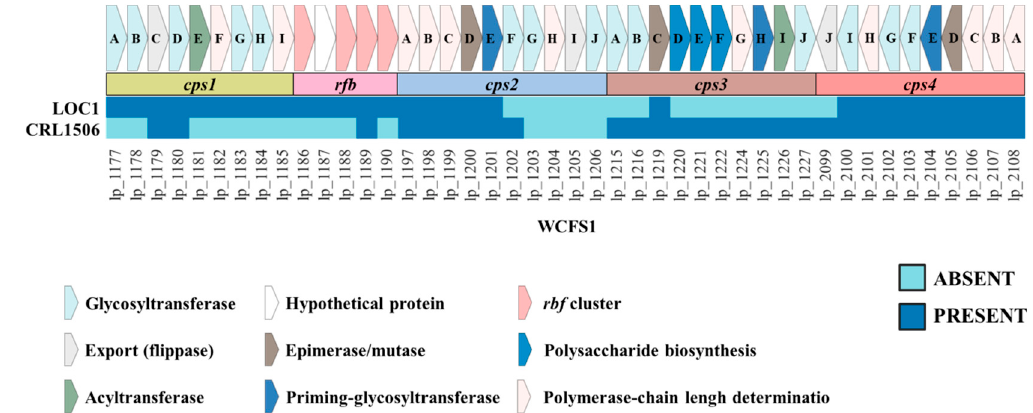
Figure 11. Analysis of the presence/absence of genes involved in the biosynthesis of exopolysaccha- rides (EPS) in Lactiplantibacillus plantarum LOC1. The genomes of LOC1 and CRL1506 strains were studied and compared with the probiotic strain WCFS1 as reference ( lp_ genes). Four clusters for EPS biosynthesis (cps1, cps2, cps3 and cps4) and the rfb cluster involved in the incorporation of rhamnose to EPS are shown.